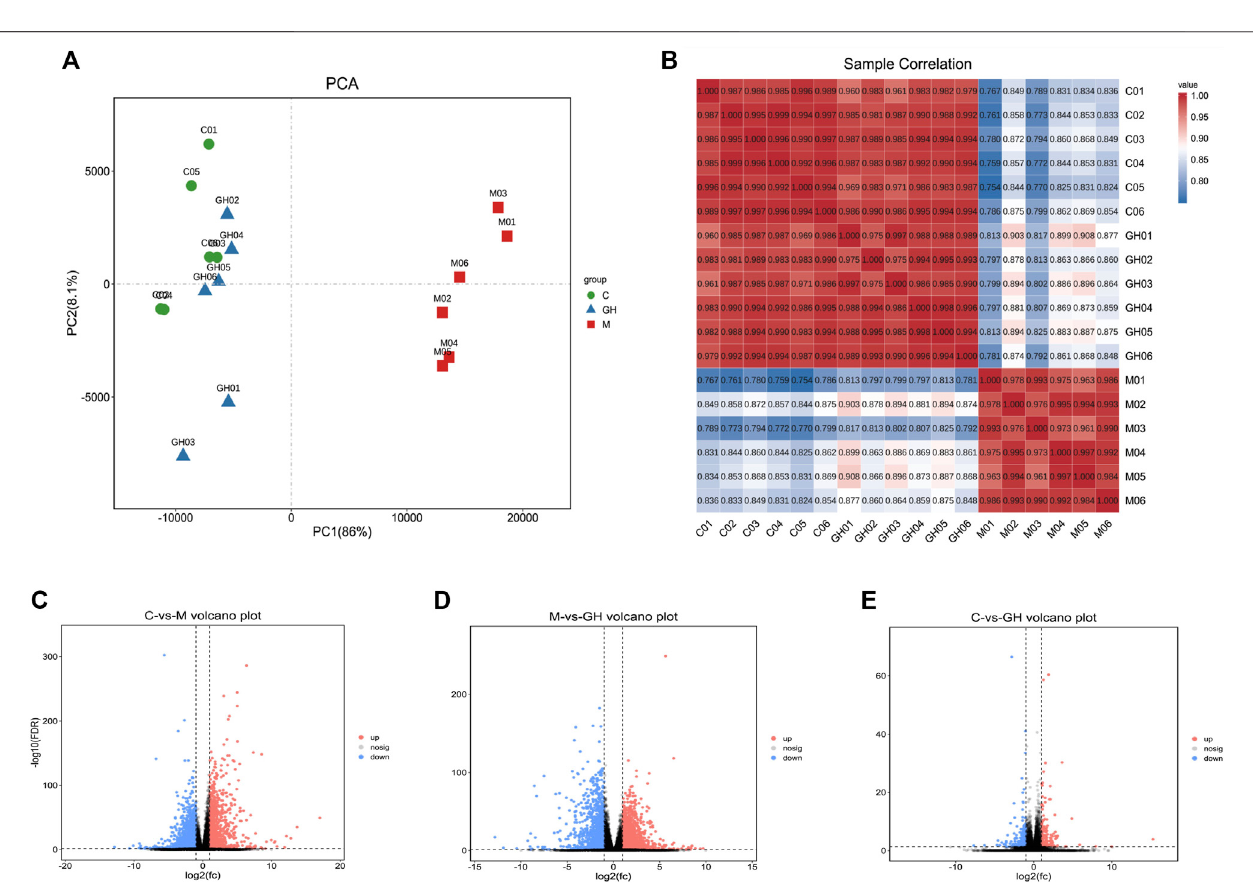
FIGURE4| Analyticaldiagramofratlungtissuesamples. (A) The fi rstprincipalcomponentisrepresentedbythePC1coordinate.Thesecondprincipalcomponent is represented by PC2 coordinates. The contribution of the principal component to the sample difference is expressed as a percentage. Groups are represented by different colored graphs. (B) Sample correlation heat map. The abscissa and ordinate in the fi gure are for each sample, and the color depth indicates the correlation coef fi cient of the two samples. The closer to red or blue, the greater the correlation, and the closer to white, the lower the correlation. (C) Comparison between blank group and model group, (D) Comparison between model group and administration group, (E) Comparison between blank group and administration group. The